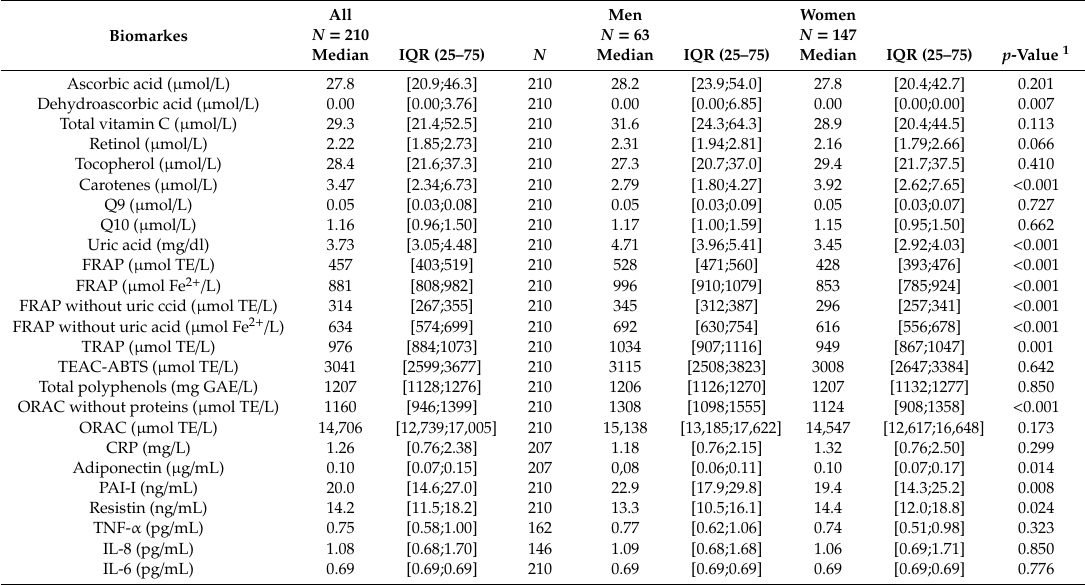
Ascorbic acid ( µ mol / L)